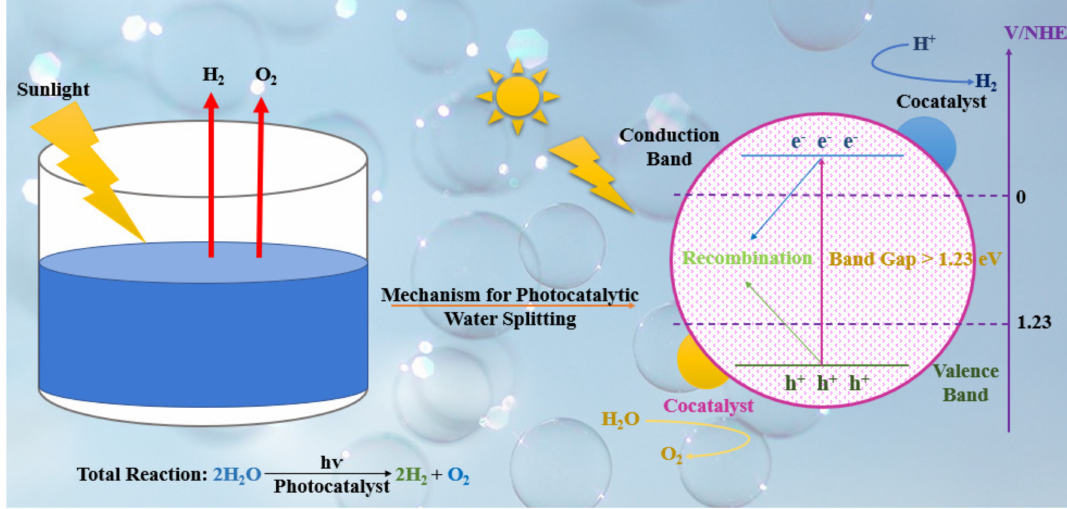
Figure 5. Mechanism of photocatalytic water splitting for hydrogen generation.